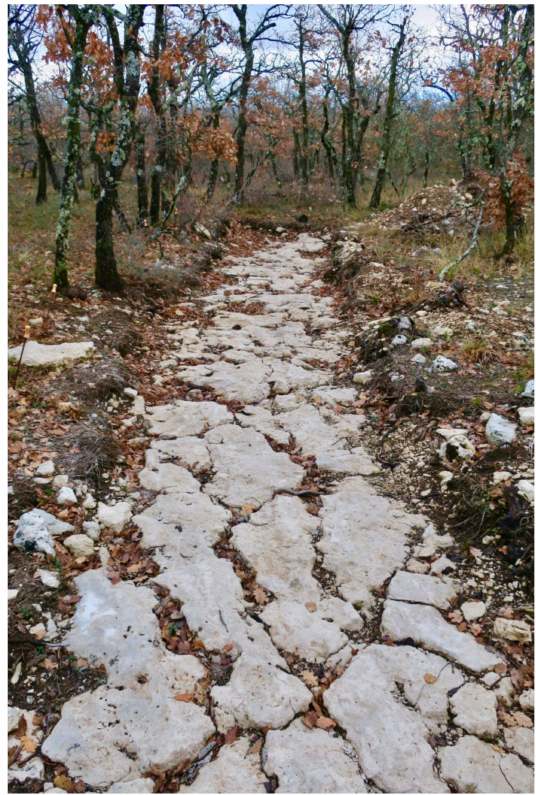
Figure 8. Trench opened in the Q. pubescens forest highlighting the shallow soil developed directly on limestone slab (credit: T.